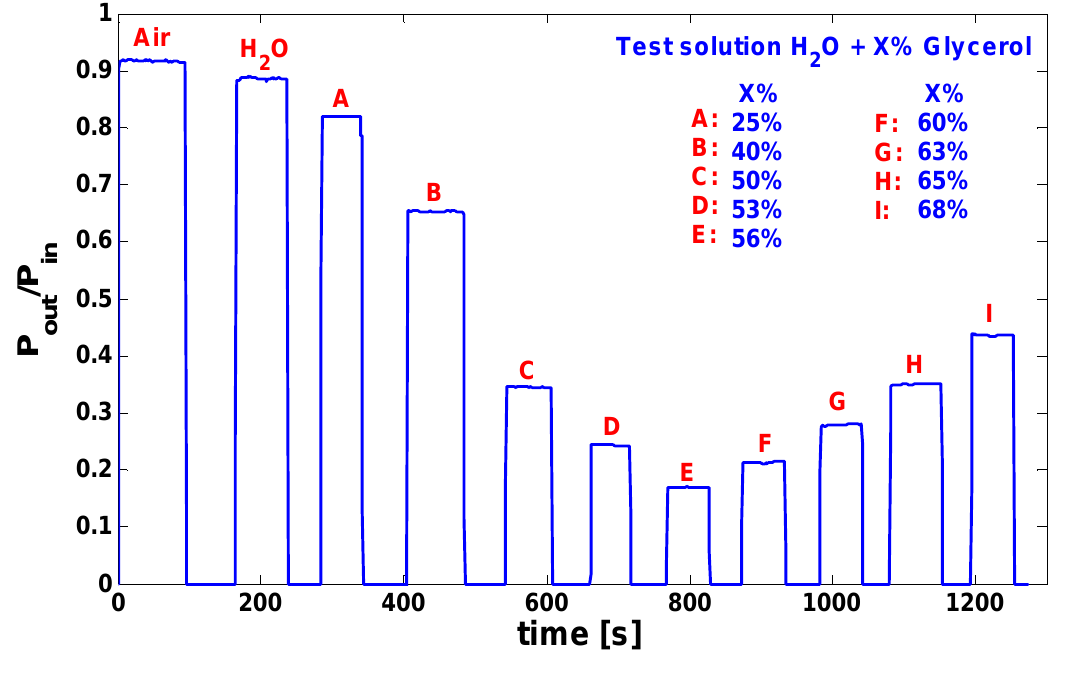
Figure 7. Real time waveguide normalized output intensity (P different flowing test solutions (Water +